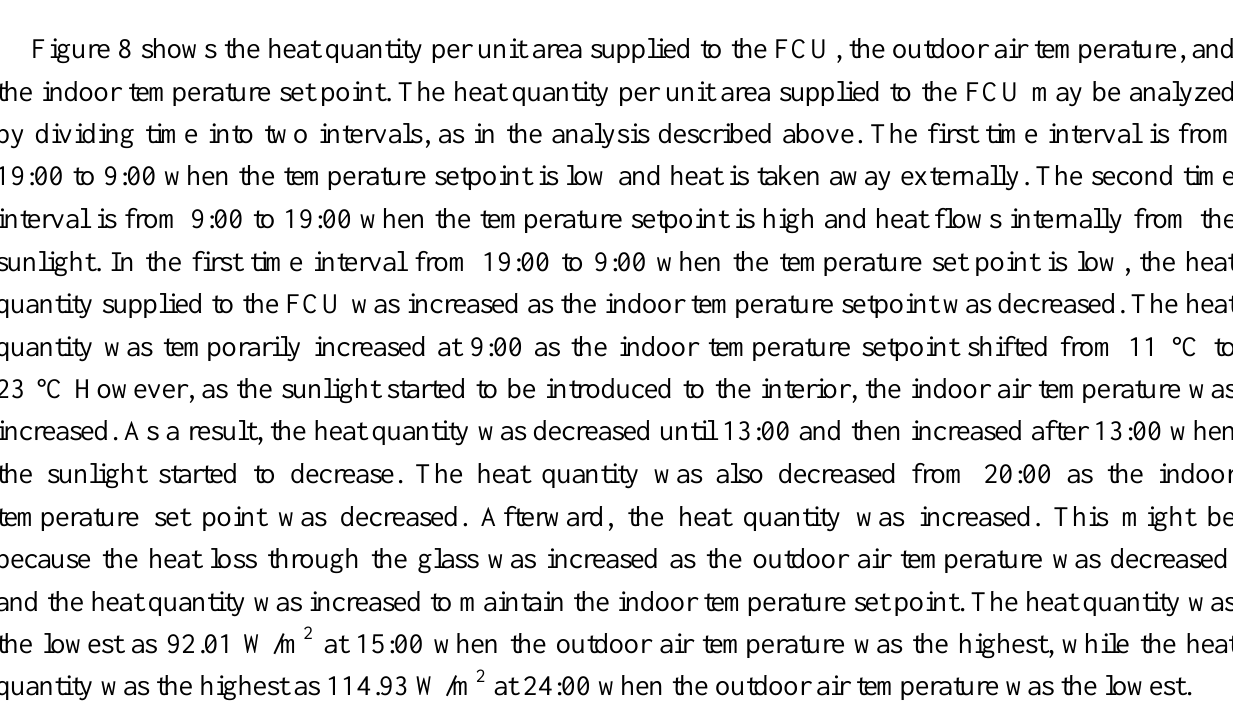
Figure 8. FCU supply heating rate